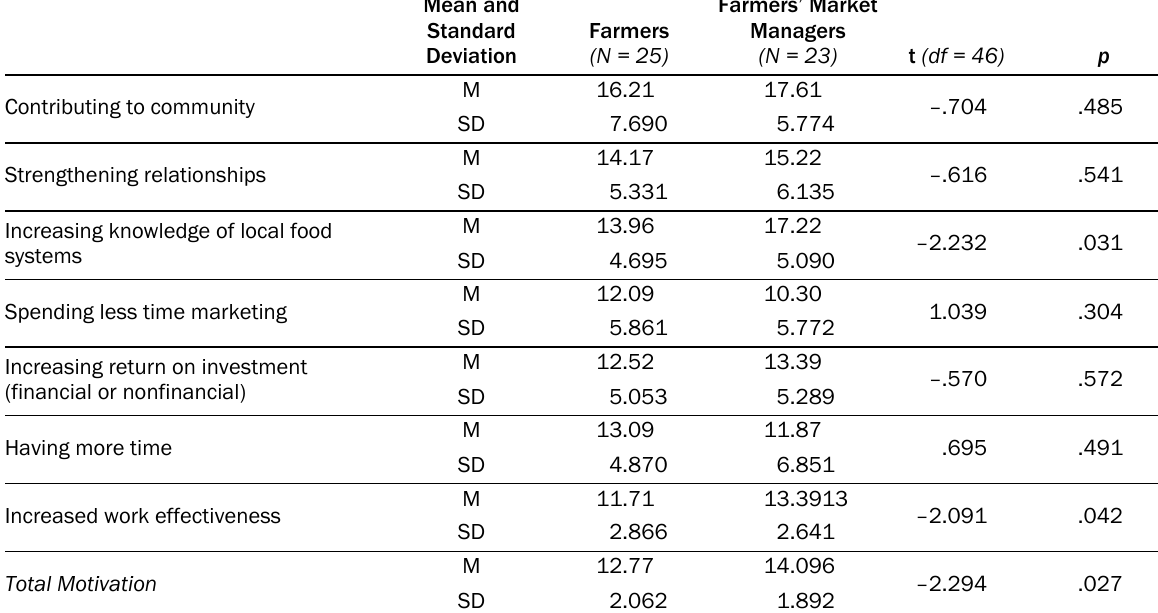
Table 6. Motivation to Collaborate: Expectancy ×